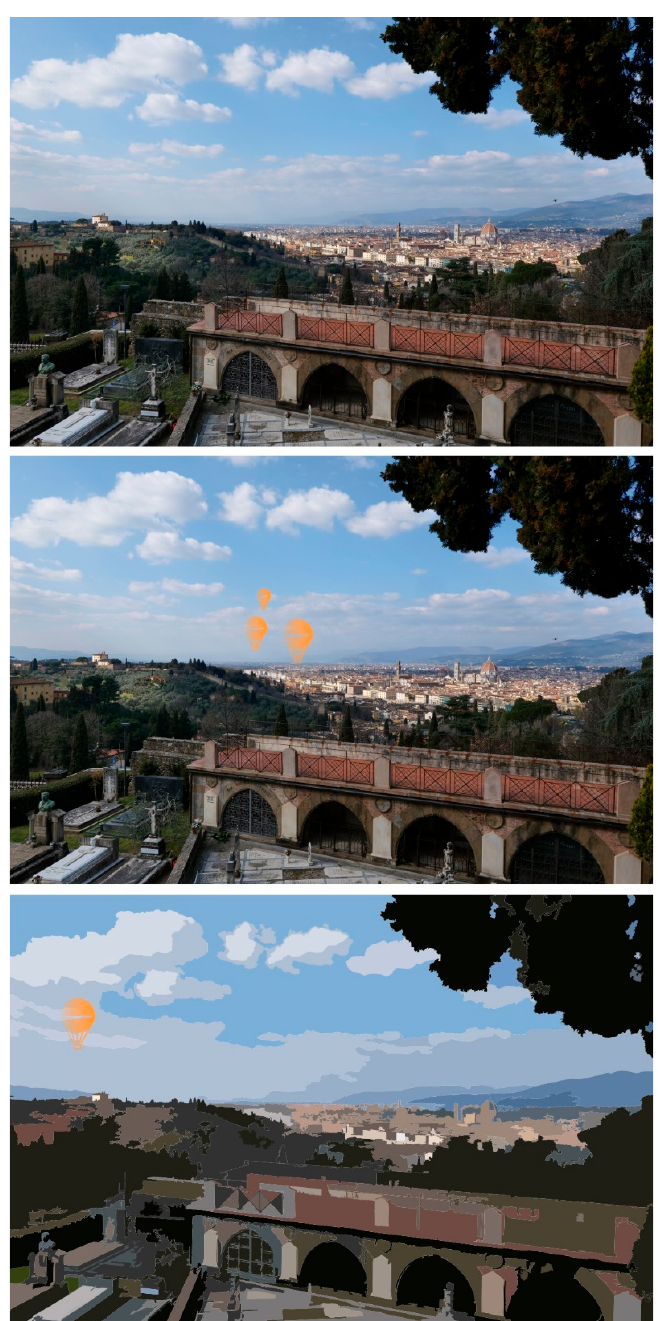
Figure 4. Visualization of the differences between the dimensions of M (material), A (augmented), and V (virtual). The basis for the visualization is the assumption that it is not a photo, but an immediate view. Above we see a Landscape M1, i.e., we recognize in a material space, Landscape 1, on the basis of which we learned as a convention (Landscape 3). The middle picture shows Landscape A1, whose M1 basis is enriched with virtual components (hot air balloons). The lower picture shows Landscape V1, as it could occur as a virtual event, e.g., in video games (photo and illustration: Olaf Kühne).